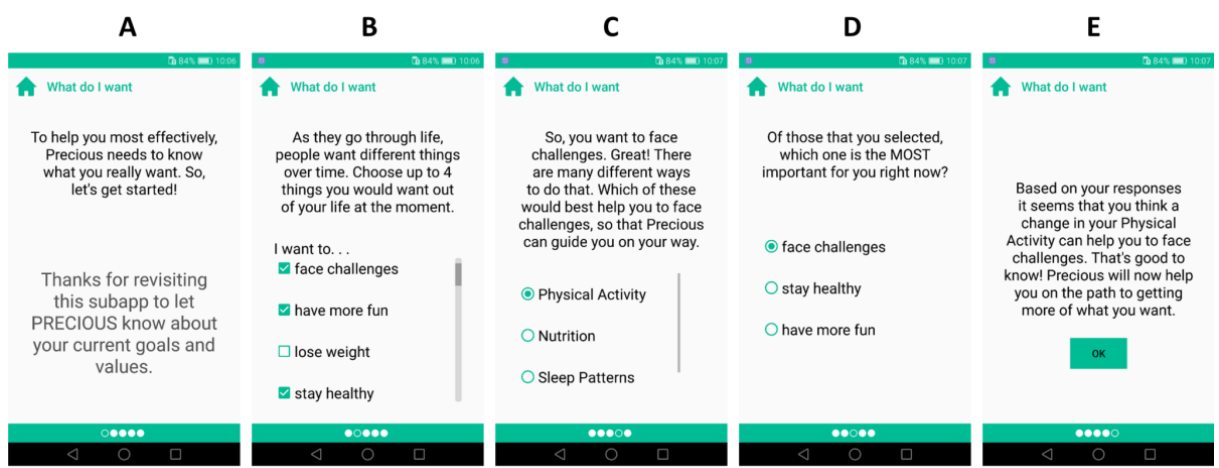
Figure 3. Implementation of the What Do I Want? tool. Screen B shows implementation of outcome goal selection, focusing on the things the user wants out of life, and Screen C allows users to indicate which of these are most important to them at this moment. Screen D provides a simple reflection on the content of the user’s chosen outcome goal and offers a menu of possible behavioral changes, which would be most likely to help them achieve the outcome goal set on Screen C. Screen E provides a summary of the user’s interaction with this tool, highlighting their chosen outcome goal and behavioral